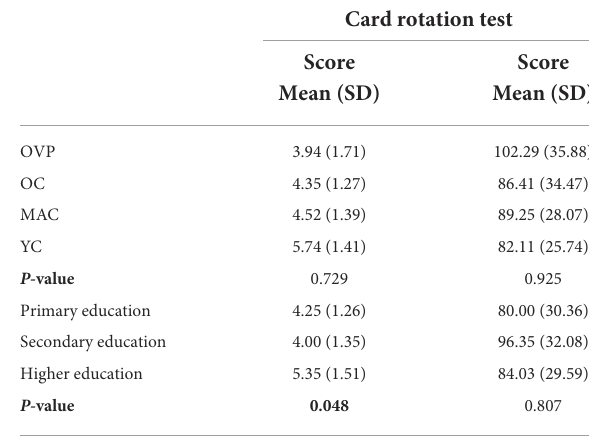
TABLE 5 Comparison of card rotation test indexes between